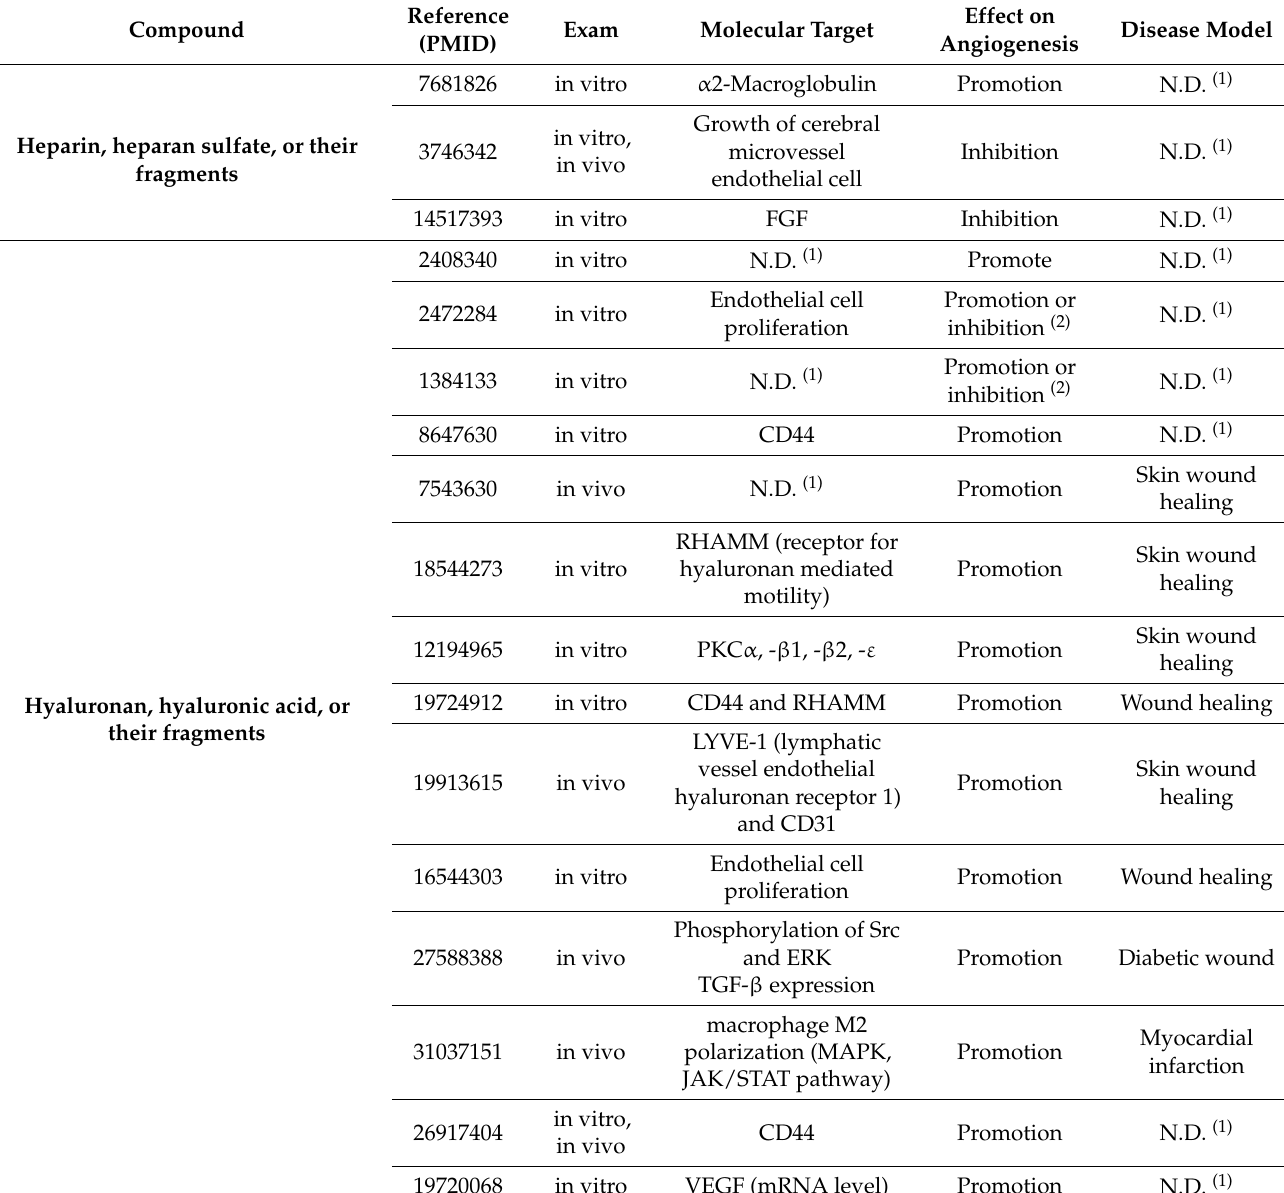
Table 1. Summary of studies investigating the effects of oligosaccharides on angiogenesis. Compound